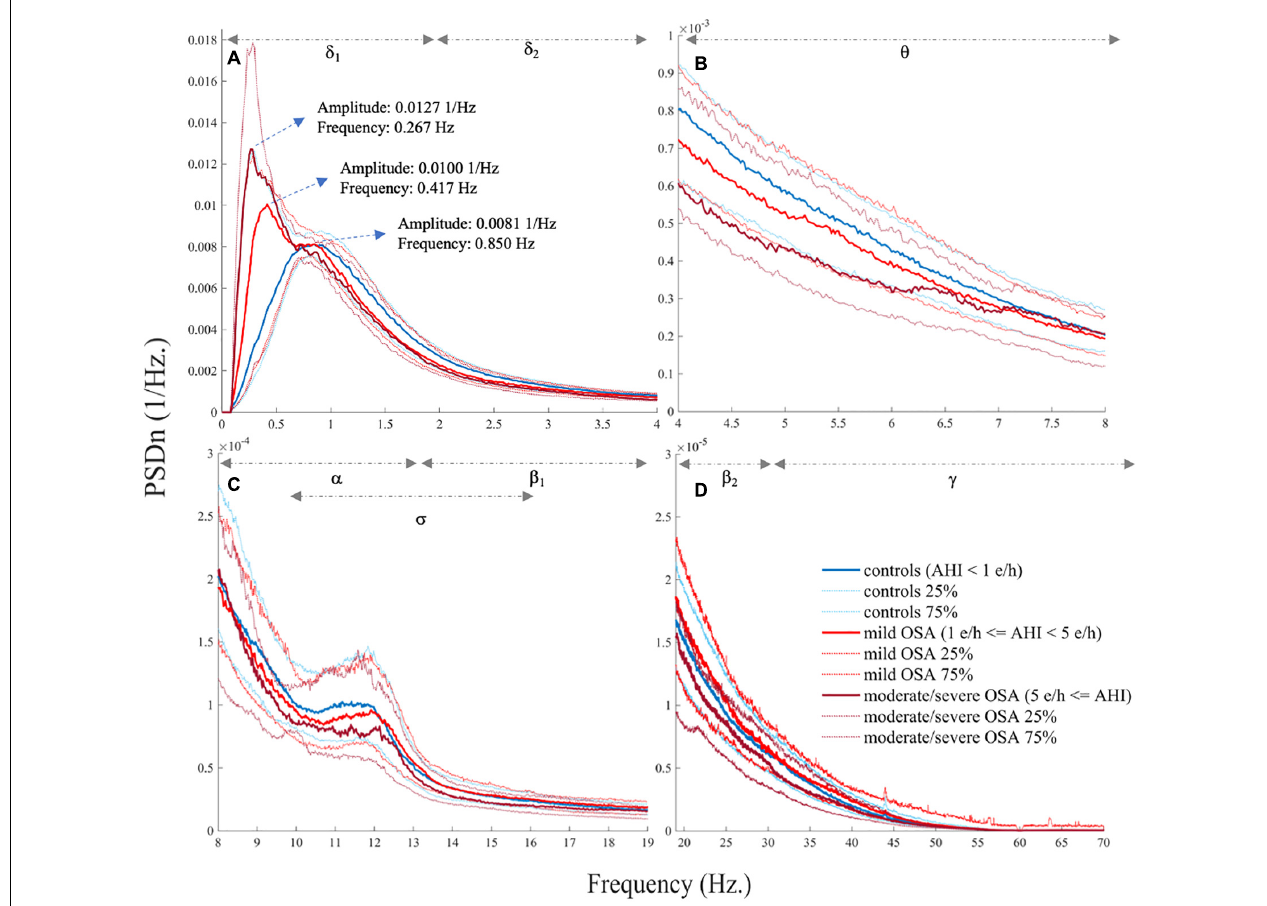
FIGURE 1 | Electroencephalogram (EEG) normalized spectrum (PSDn) averaged for the three obstructive sleep apnea (OSA) severity groups (median, 25%, and 75% quartiles), showing (A) δ 1 and δ 2 , (B) θ , (C) α , σ , and β 1 , and (D) β 2 and γ